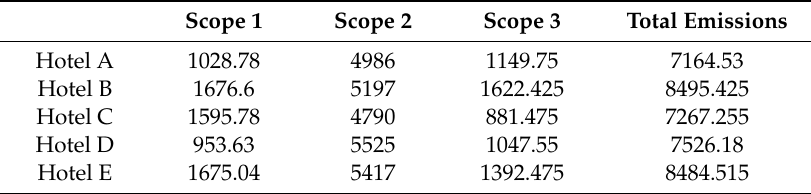
Table 4. Contribution of various scopes towards total GHG